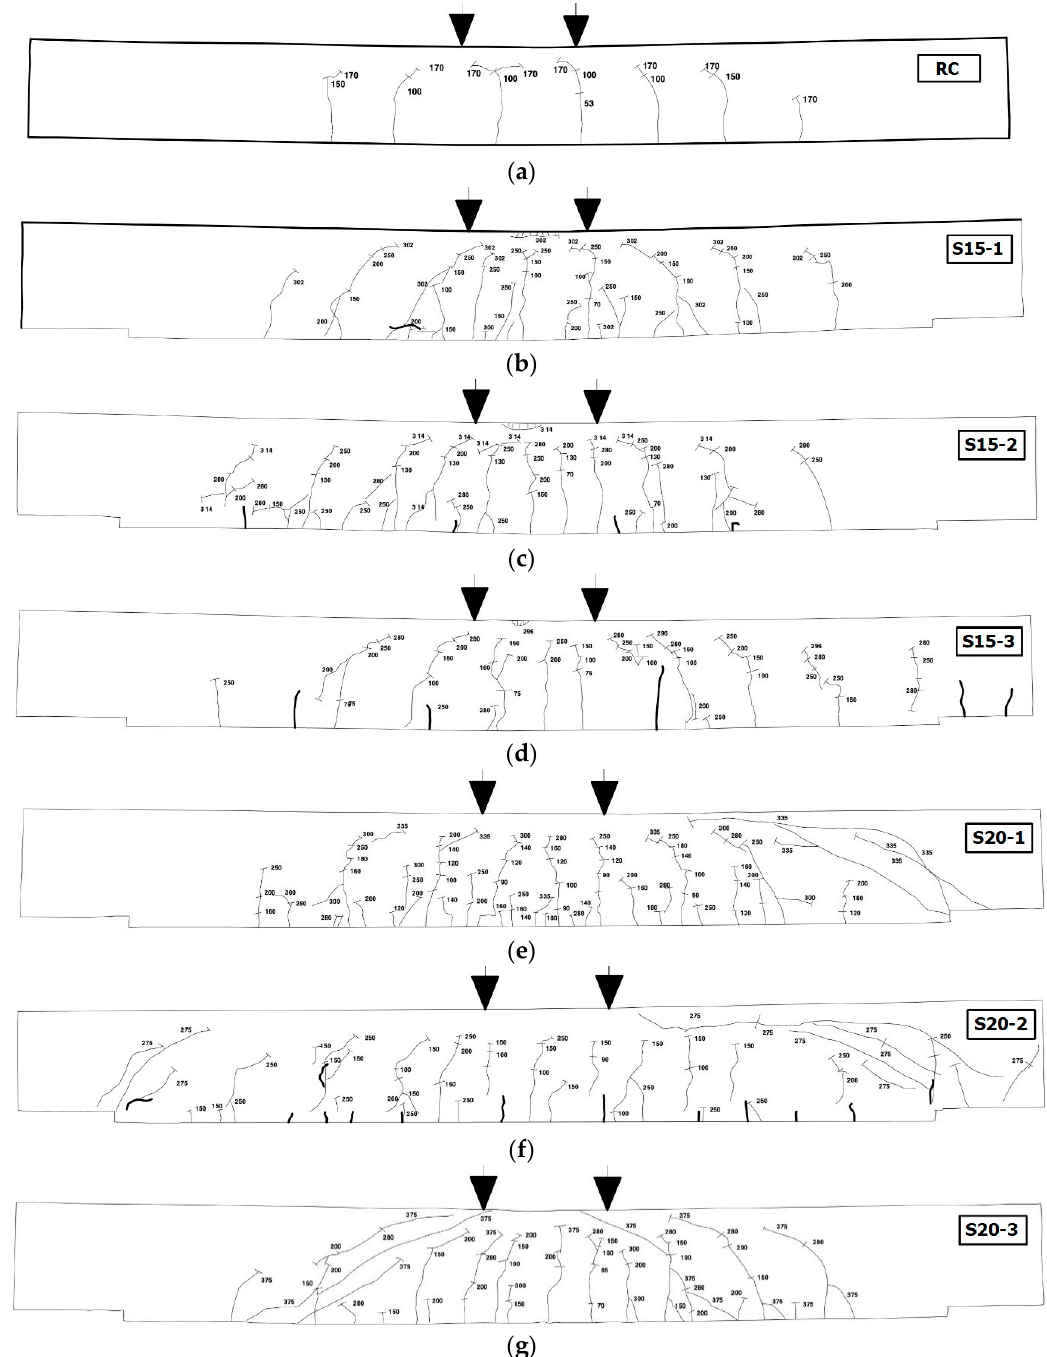
Figure 10. Cracked patterns on the bottom side of specimens after failure (photo). ( a ) RC; ( b ) S15-1; ( c ) S15-2; ( d ) S15-3; ( e ) S20-1; ( f ) S20-2; ( g ) S20-3.